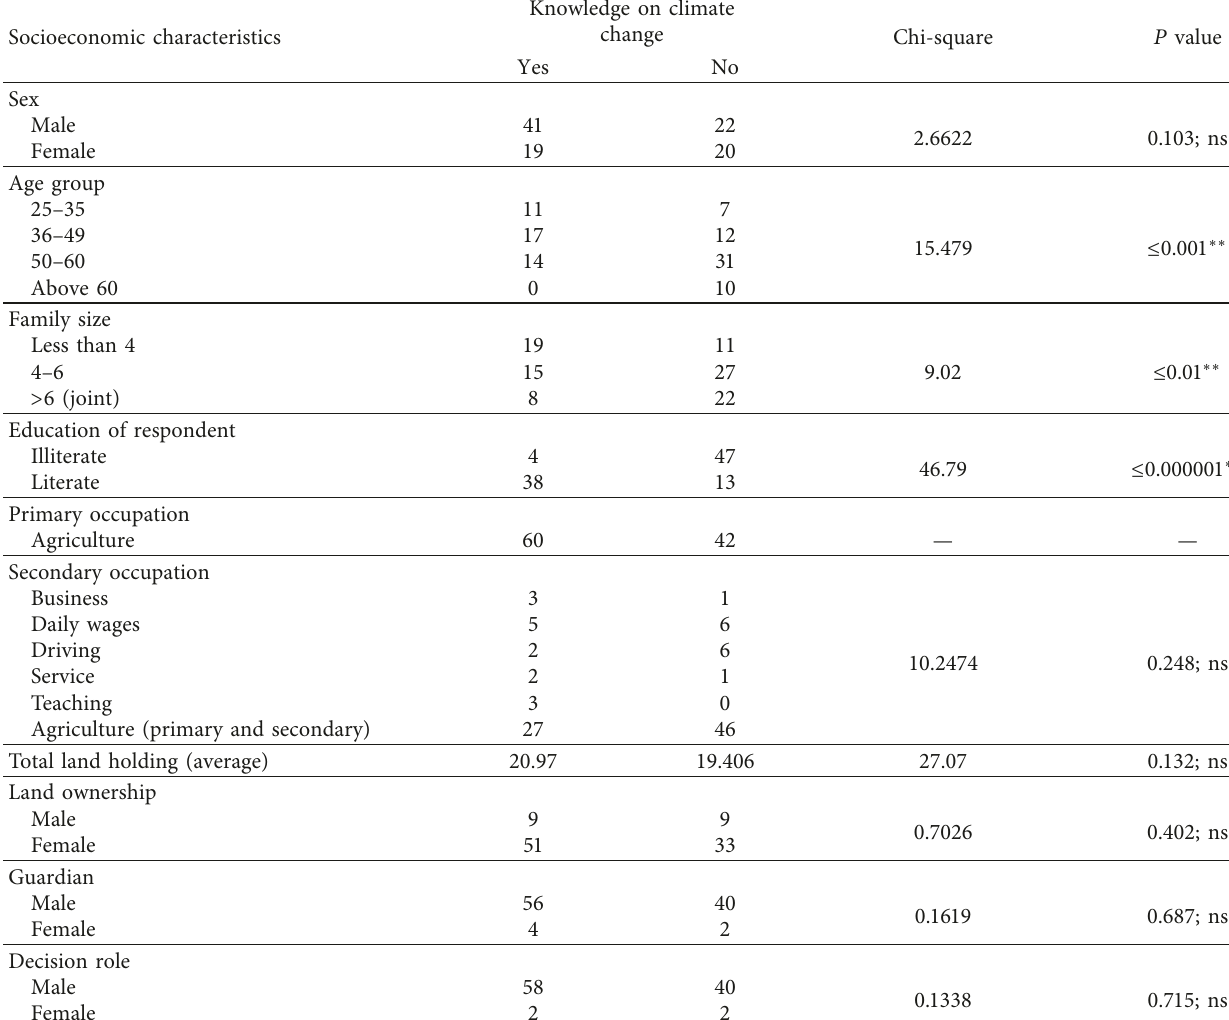
Table 2: Socioeconomic characteristics and association with knowledge of climate change.